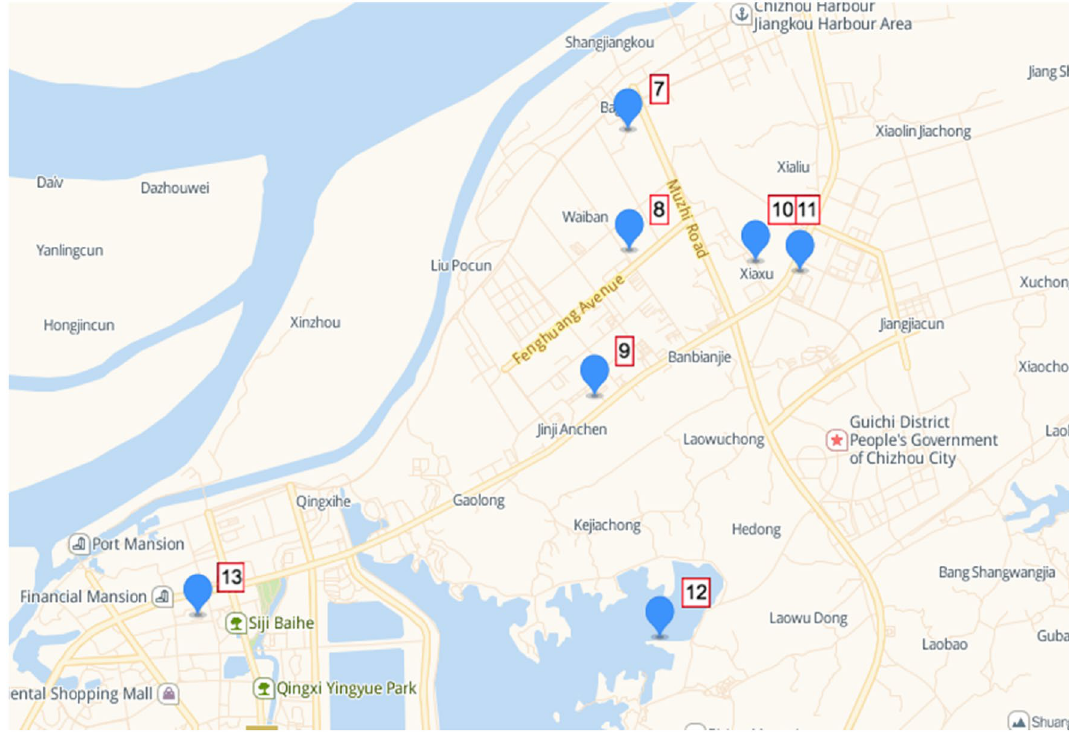
Figure 6. Distribution chart of monitoring points in Chizhou, Anhui Province. (From: Bai du map).